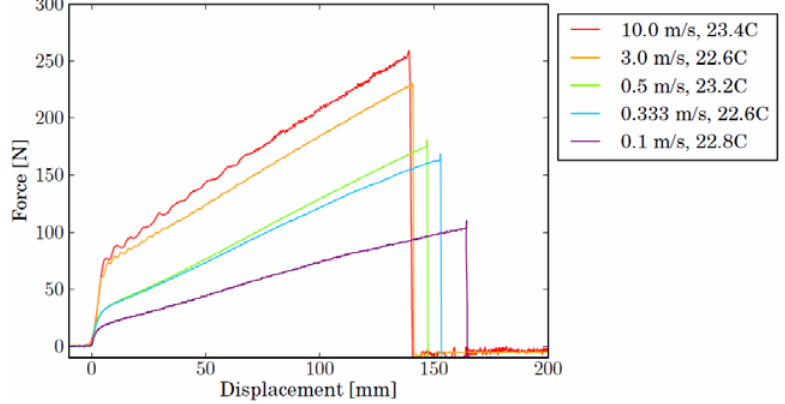
Fig. 8 Uniaxial tensile tests of PVB at various crosshead speeds: force vs.